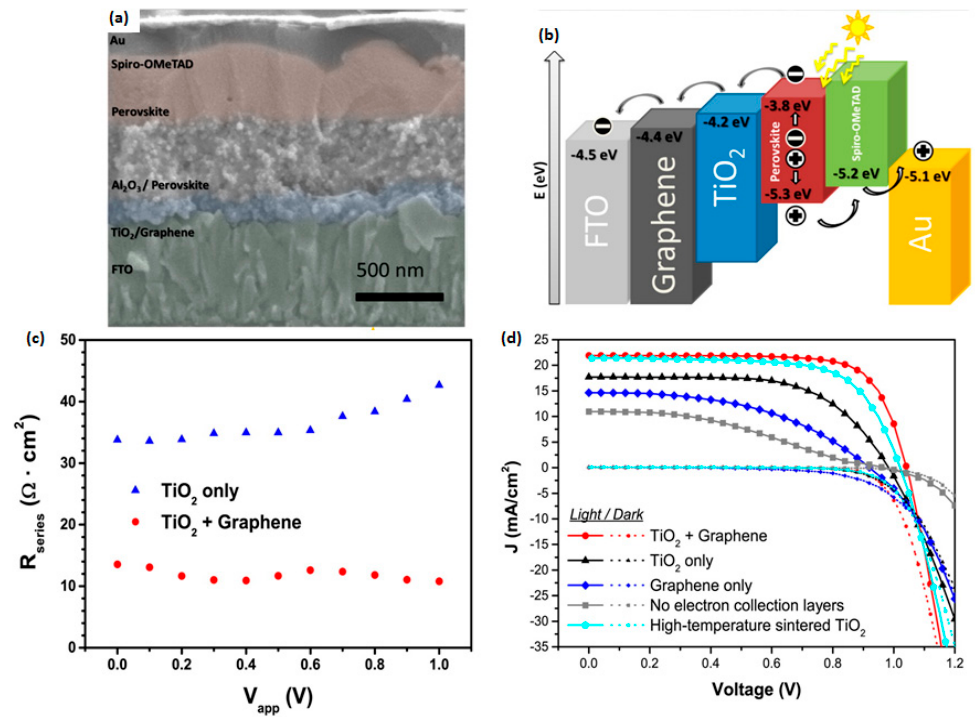
Figure 6. ( a ) Cross-sectional SEM image and ( b ) energy levels of the PSC with a graphene-TiO 2 composite as the electron transport layer (ETL). ( c ) The series resistance of the perovskite solar cells (PSCs) with a graphene-TiO 2 composite or TiO 2 only as the ETL. ( d ) J-V characteristics of the PSCs with different electron collection layers under AM 1.5G and dark [60].